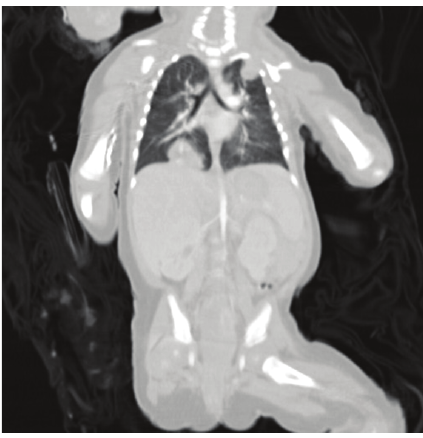
Figure 3: CT of the chest with